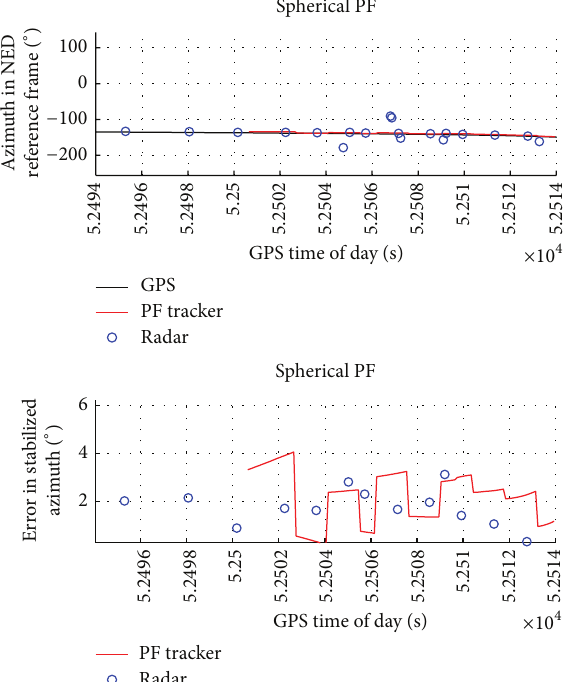
Figure 6: Azimuth in NED reference frame as estimated by GPS, by radar, and by radar-only tracker and estimation error as a function of GPS time of